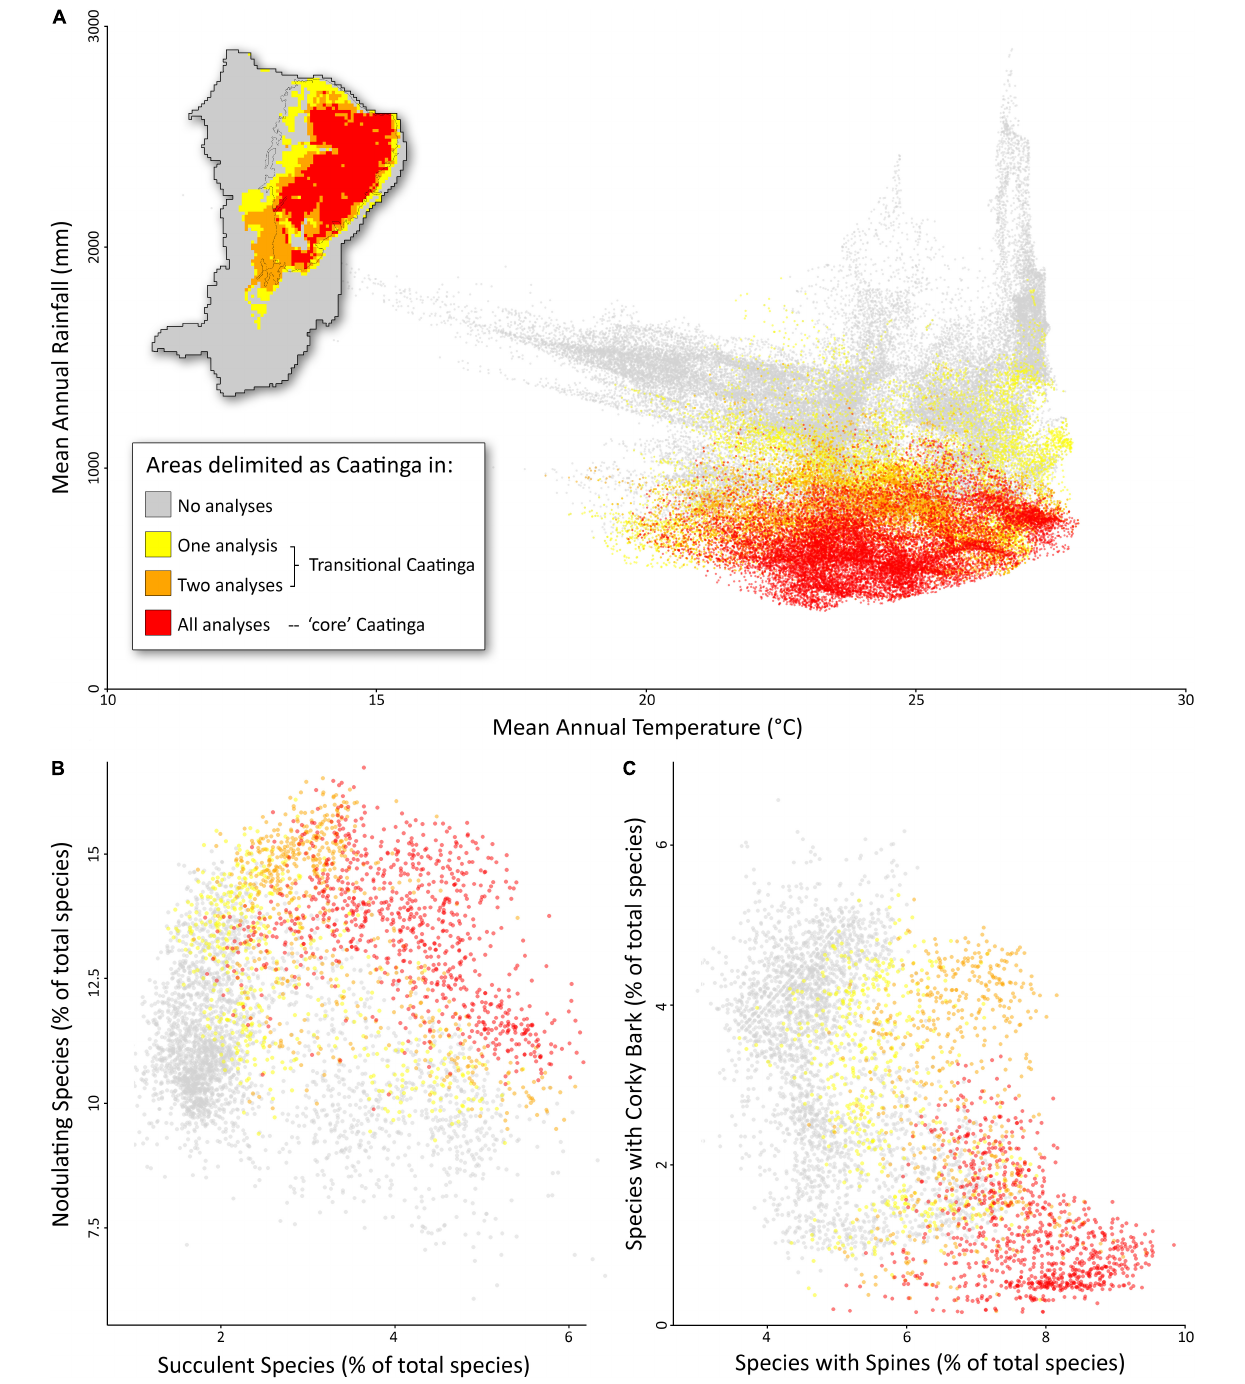
FIGURE 4 | Distribution of the Caatinga seasonally dry forest biome within NE Brazil in geographic, environmental (A) and trait (B,C) space. Colors indicate areas delimited as Caatinga in no analyses (gray), one or two analyses (“transitional Caatinga,” yellow and orange), and three analyses (“core” Caatinga, red). The black line in the map indicates the limits of the Caatinga domain sensu Instituto Brasileiro de Geografia e Estatística (IBGE) (2012).